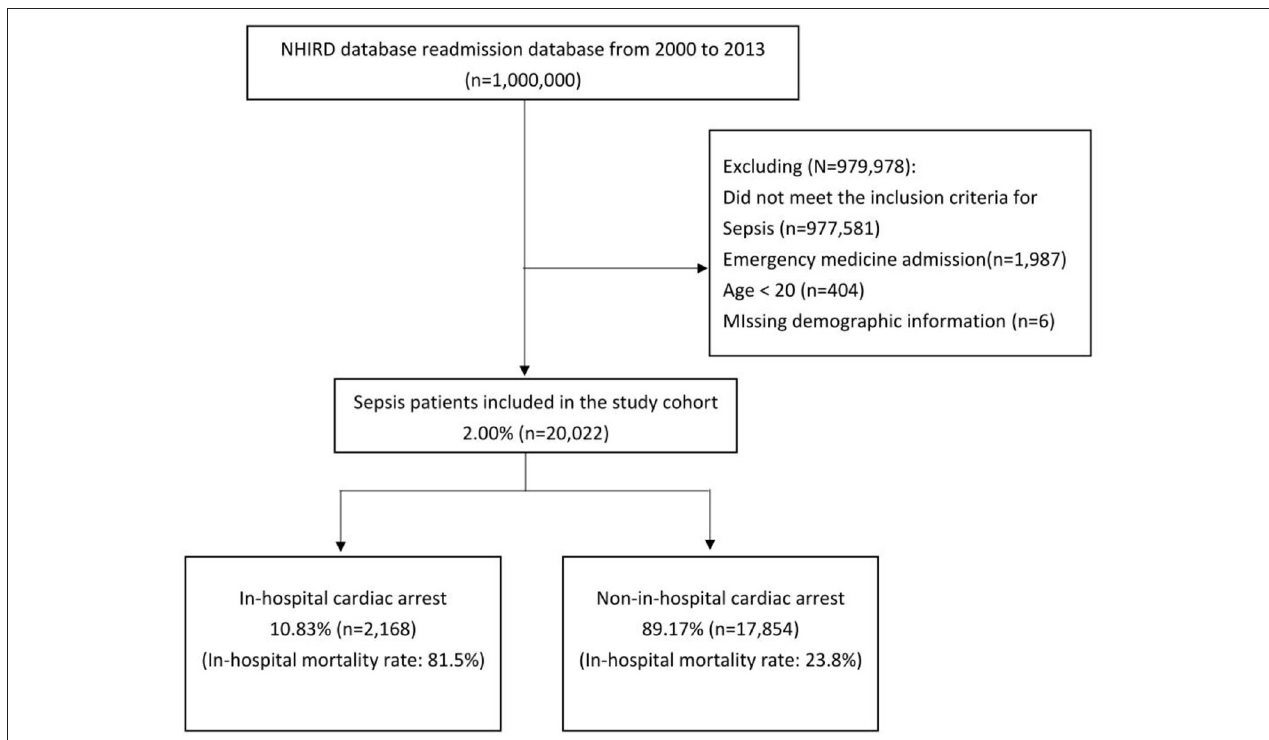
FIGURE 1 | Study cohort. We identified 20,022 patients with sepsis from 2000 to 2013. In this cohort, 10.83% of the patients developed IHCA.